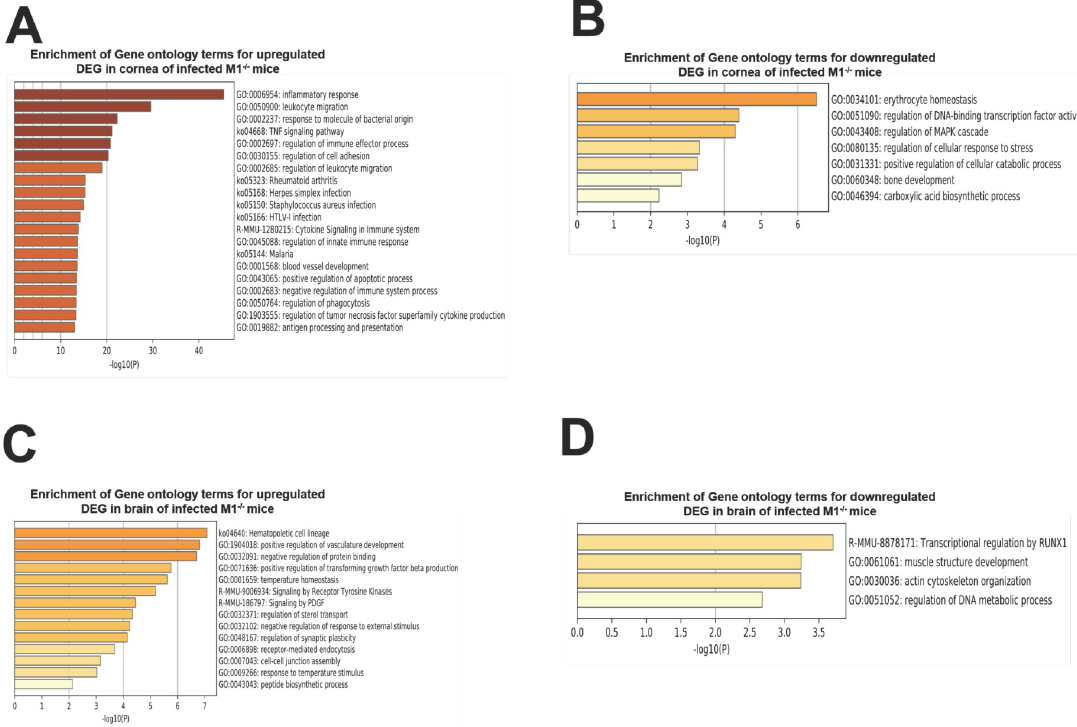
Fig 9. Gene ontology expression in corneas and brain of infected WT and M1 -/- mice. A and B) Upregulated and downregulated pathways in corneas of infected M1 -/- mice. Following Nanostring analysis, the genes were further analyzed by Metascape and based on this analysis the top two upregulated pathways in infected corneas were: inflammatory response (GO: 0006954) and leucocyte migration (GO: 0050900). The top two downregulated pathways were: erythrocyte homeostasis (GO:0034101) and regulation of DNA-binding transcription factor activity (GO: 0051090); and B and C) Upregulated and downregulated pathways in brain of infected M1 -/- mice. The top two upregulated pathways in infected brains were: Hematopoietic cell lineage (GO: ko04640) and positive regulation of vasculature development (GO:1904018). The top two downregulated pathways were: transcriptional regulation by RUNX1(R-MMU-8878171) and muscle structure development